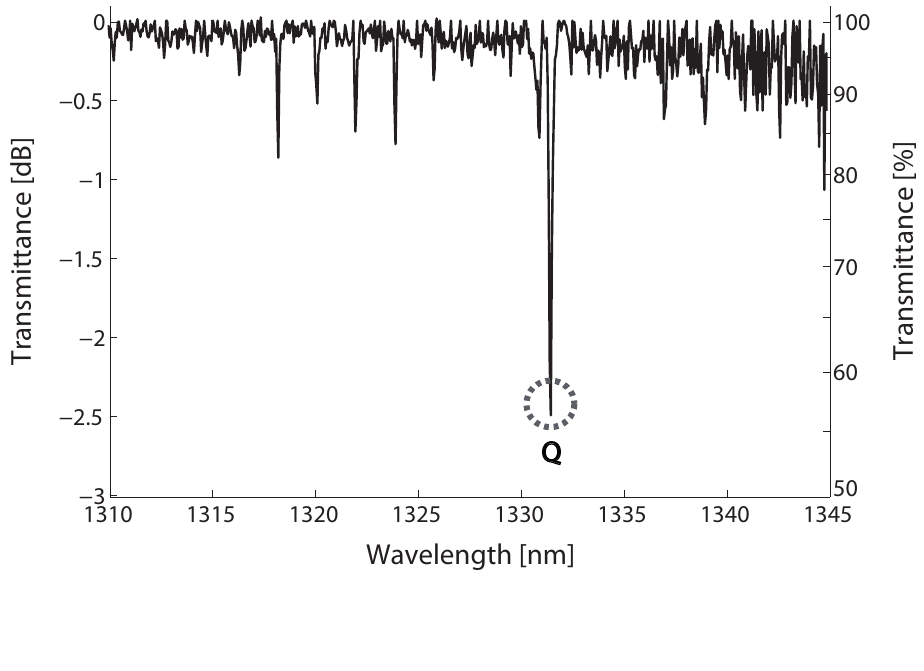
Figure 4. Transmission spectrum of the ν at relative pressure of 1 bar, room temperature and 18750 ppmv calibrated concentration of methane in